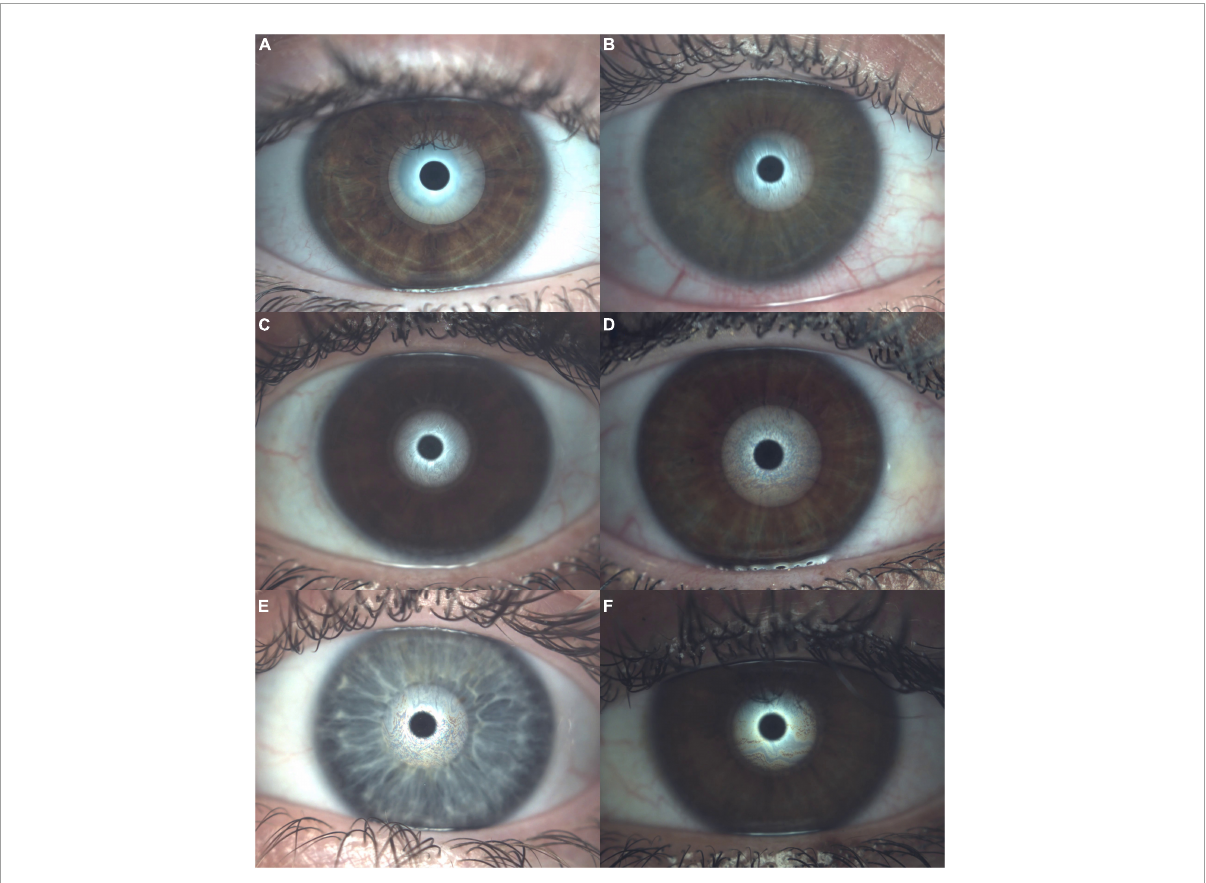
FIGURE3 Lipid layer thickness assessment within the optic interferometer. (A) No lipid present ( < 15 nm of lipid thickness). (B) Open meshwork pattern ( ∼ 15 nm of lipid thickness). (C) Close meshwork pattern ( ∼ 30 nm of lipid thickness). (D) Wave pattern ( ∼ 30/80 nm of lipid thickness). (E) Amorphous pattern ( ∼ 80 nm of lipid thickness). (F) Color fringes pattern ( ∼ 80/120 nm of lipid thickness) and no patient achieved abnormal color ( ∼ 120/160 nm of lipid thickness).